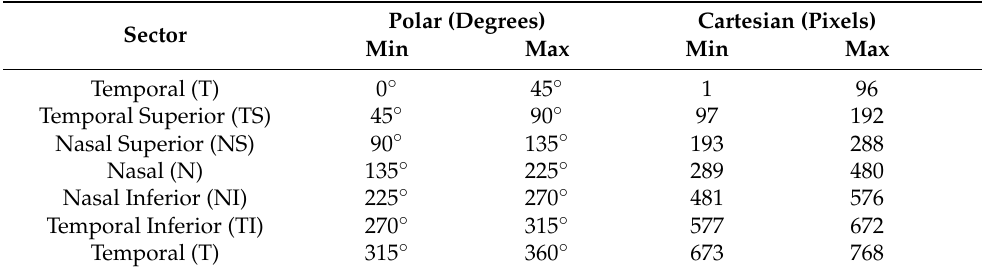
Table 2. Correspondence between the polar and Cartesian coordinates in the OCT projection.